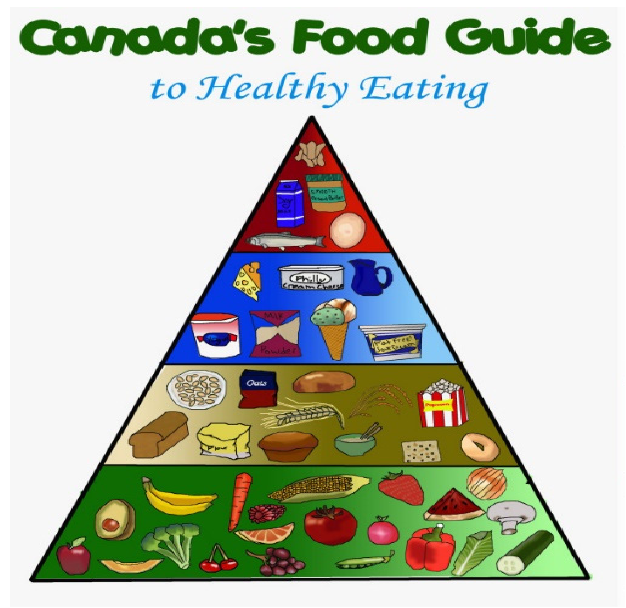
Figure 5. The Canadian food guide.